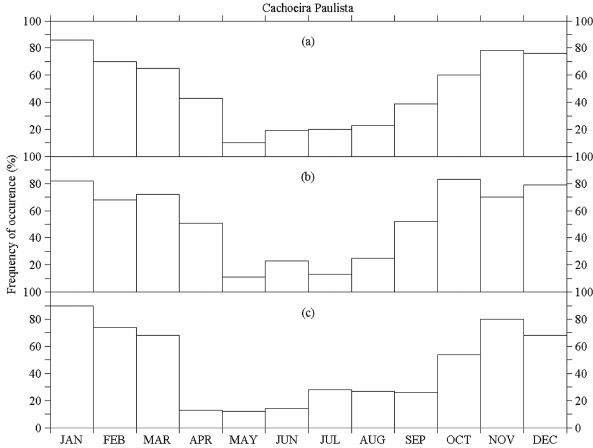
Fig. 3. Frequency of occurrence of the plasma bubbles over Ca- choeira Paulista. After Sobral et al. (2002). (a) complete solar cycle